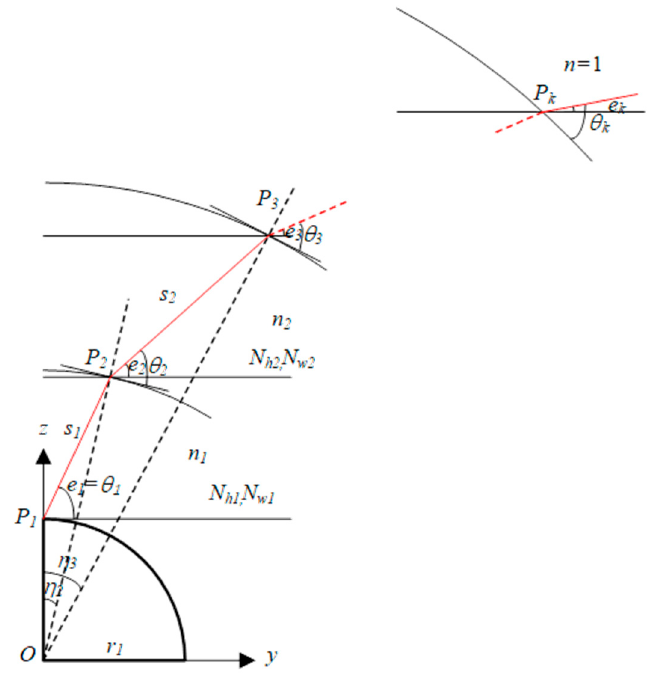
Figure 1. Geometry of ray-tracing with the piecewise-linear (PWL) approach.